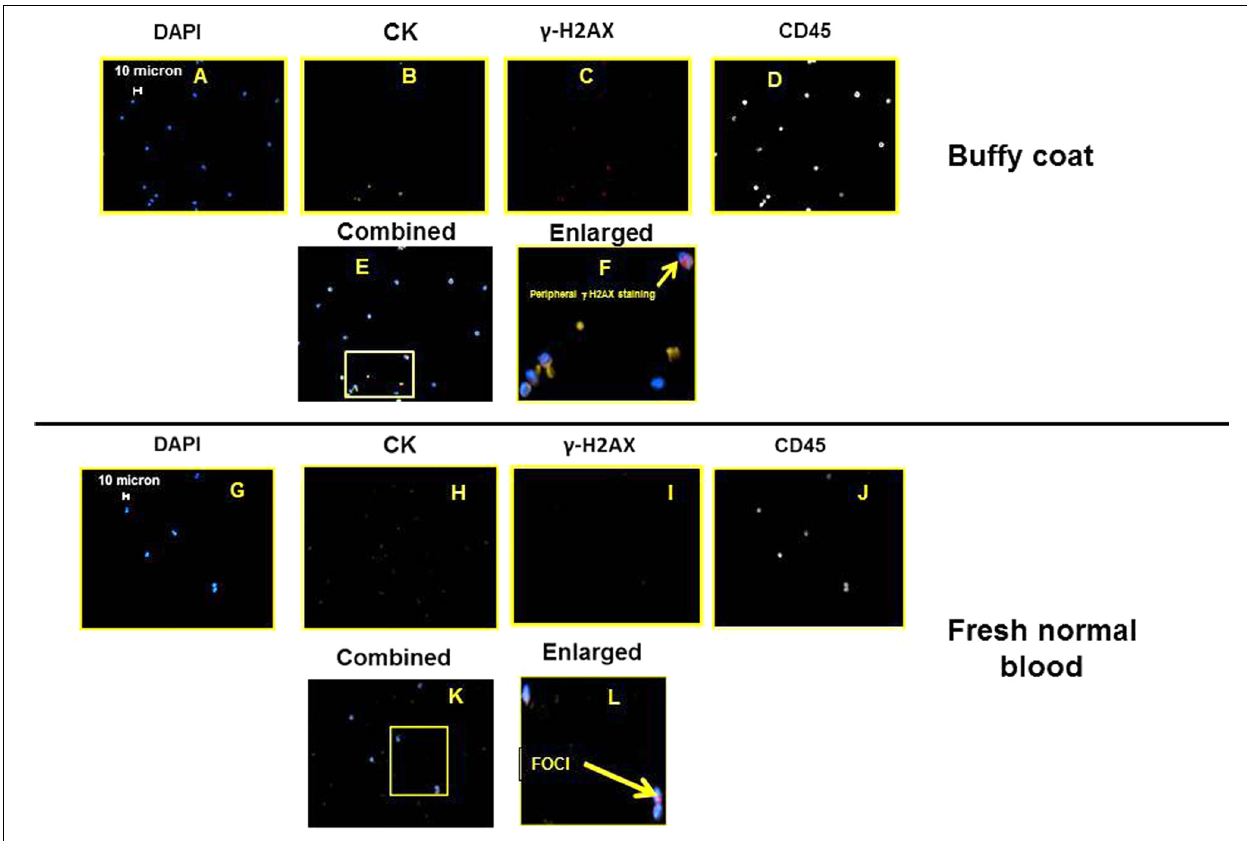
FIGURE 3 | Sets of epifluorescent images (A–F) for buffy coat and (G–L) for fresh, normal blood. For (A–F) and (G–K) , images are the same location, different filter settings corresponding to the stained marker/structure targeted and listed above the image. Figures (F) and (L) are the enlargements highlighted (E) and (K) ,